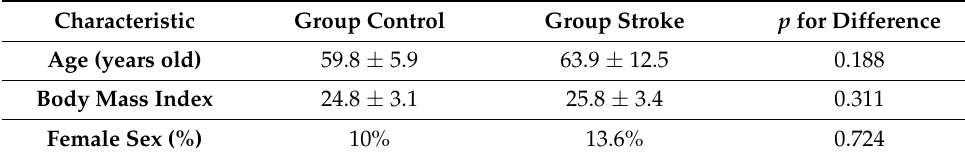
Table 1. Comparison of demographic characteristics between the two groups. Characteristic Group Control